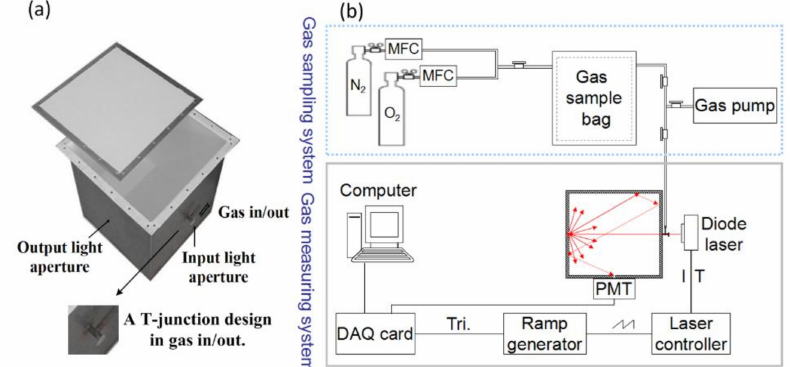
Figure 2. ( a ) Structure of a cubic diffuse integrating cavity; ( b ) schematic of the gas-sampling system and TDLAS (tunable diode laser absorption spectroscopy) for measuring the absorption of oxygen with a cubic cavity as the gas